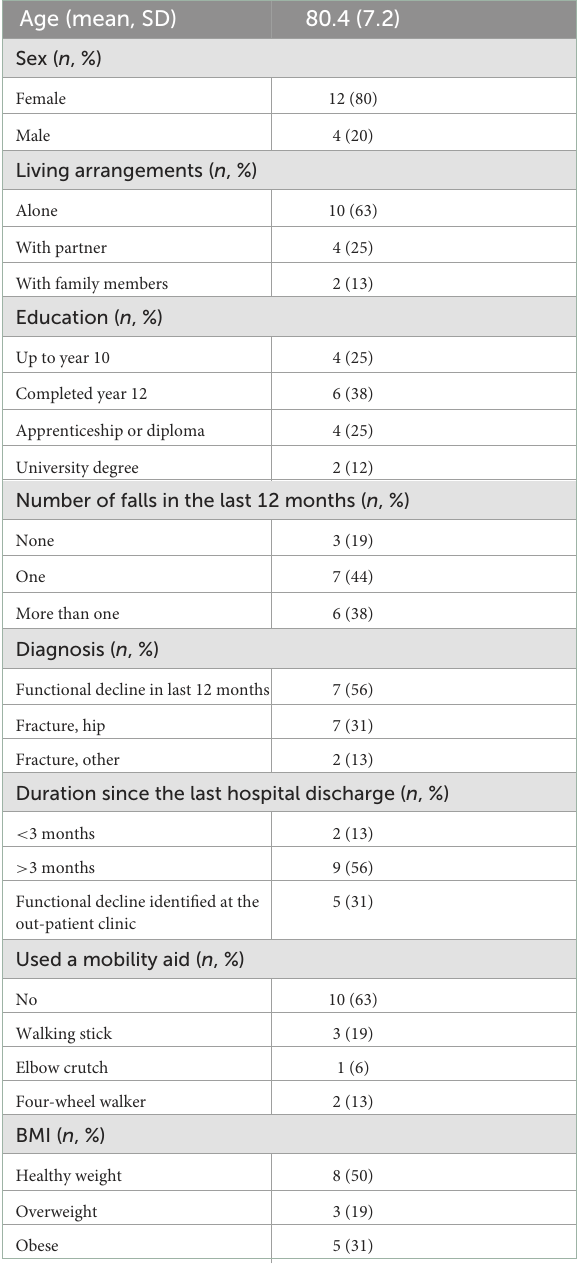
TABLE 1 Demographic characteristics of participants ∗